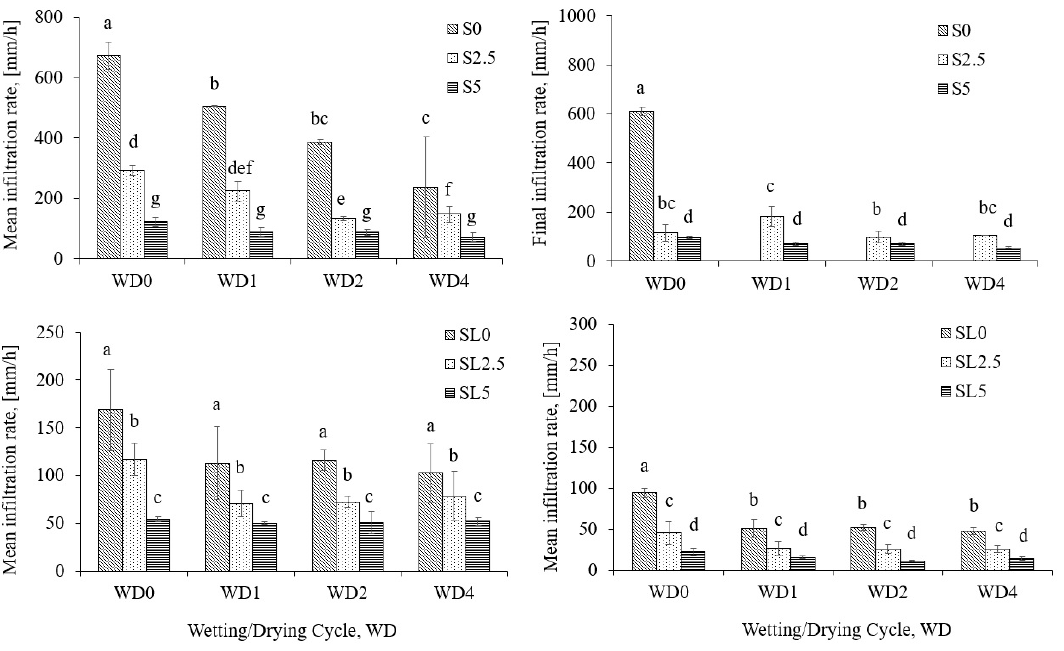
Figure 1. Measured mean infiltration rate ( i ) and final infiltration rate ( Ib ) for the sandy (S) and sandy loam (SL) treatments during di ff erent wetting and drying cycles (WD). Same letters in the same treatment at di ff erent WD cycles are significantly similar ( p < 0.05). Error bars denote standard deviation from the mean (N = 3).